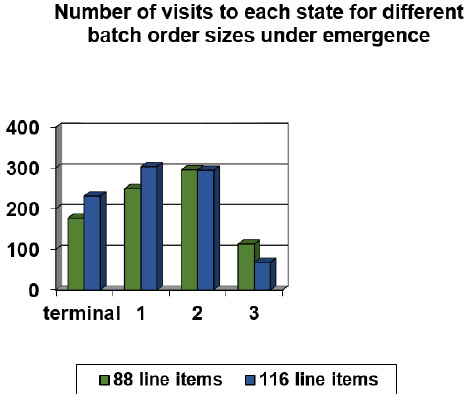
Figure 12. The number of agent visits to each state for the scheduling of one batch of 28 orders and four emergency orders, with mean order size (i) three line items per order; and (ii) four line items per order, when the agent selected the second policy action. The agent followed an ε-greedy policy with ε = 0.2.